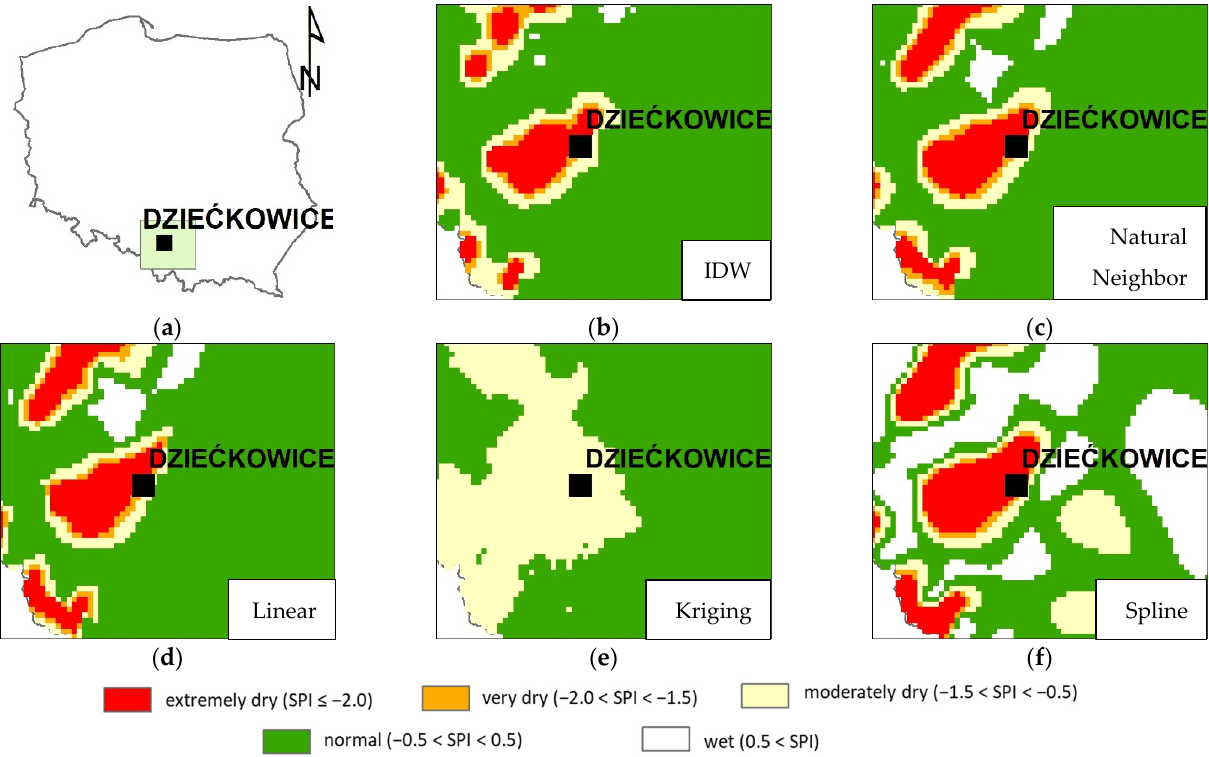
Figure 8. Explanation of disturbances in the measurements at the control station of Dzie ć kowice, January 2015. Part ( a ) presents localization of control station in Poland. The other parts show interpolation of SPI-1 with different methods: ( b ) Inverse Distance Weighted, ( c ) Natural Neighbor, ( d ) Linear method, ( e ) Kriging, ( f ) Splines.